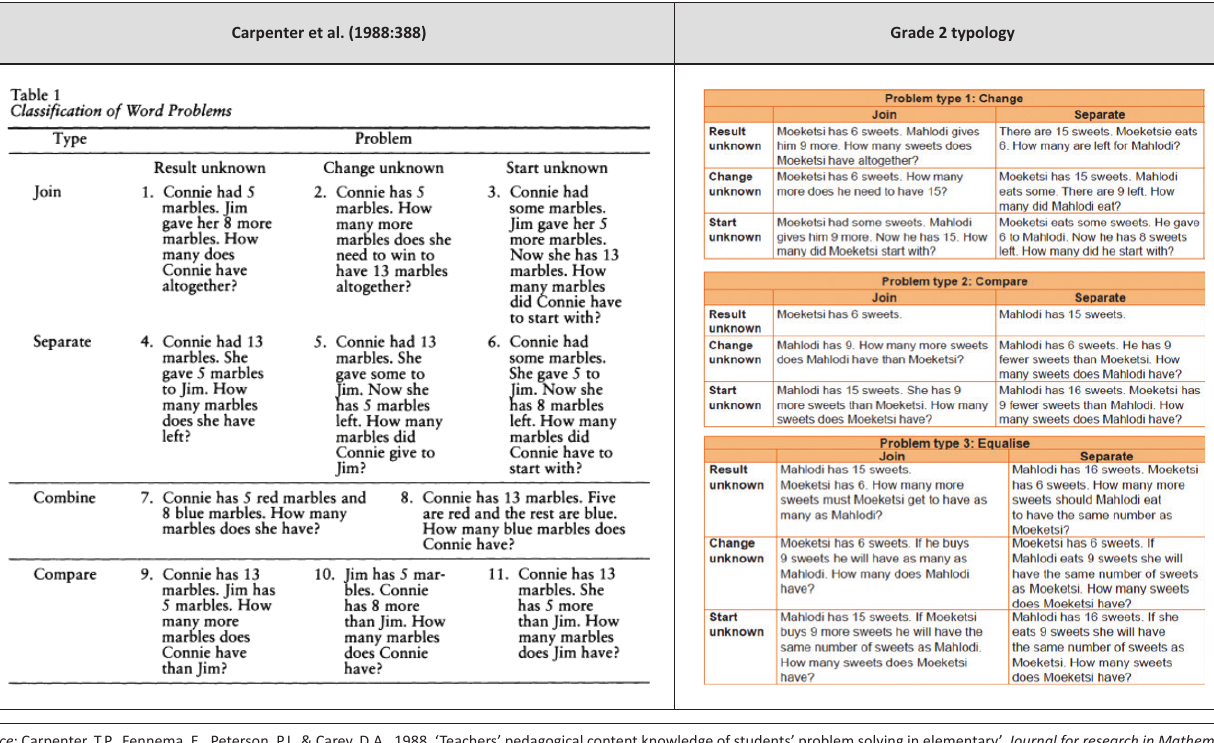
FIGURE 11: Tables showing ambiguous and incorrect formatting for ‘unknown’